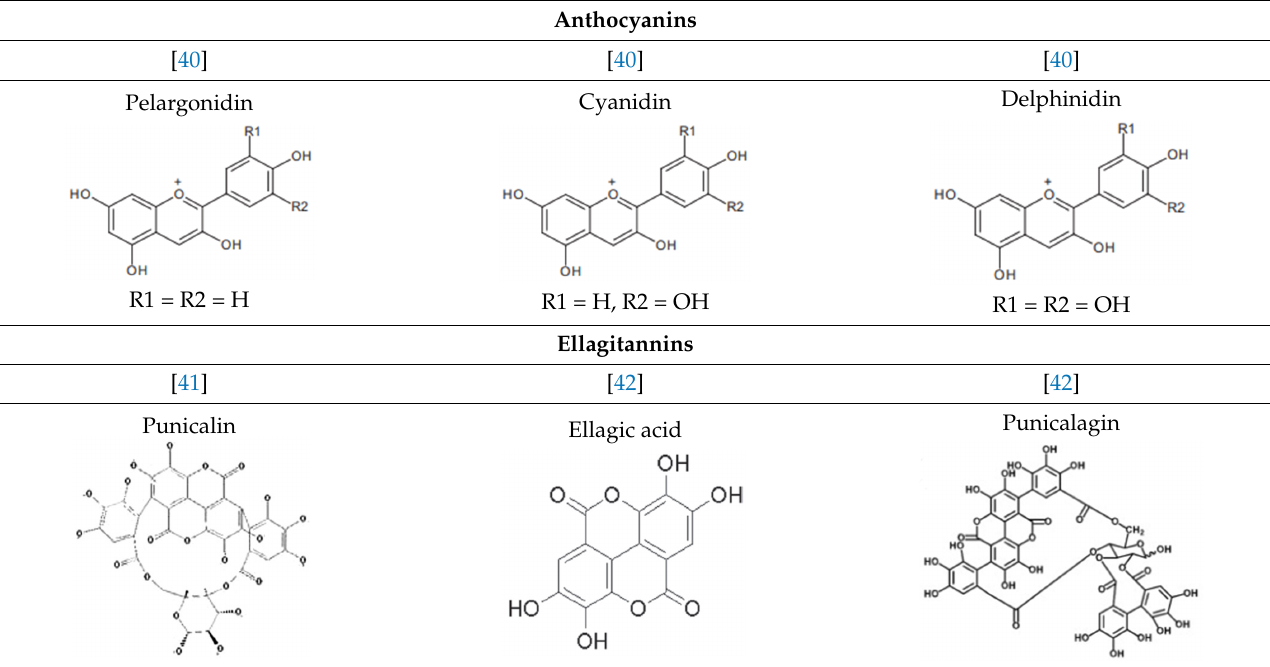
Table 1. Summary of the most important groups and subgroups of polyphenol compounds present in Punica granatum L. Anthocyanins